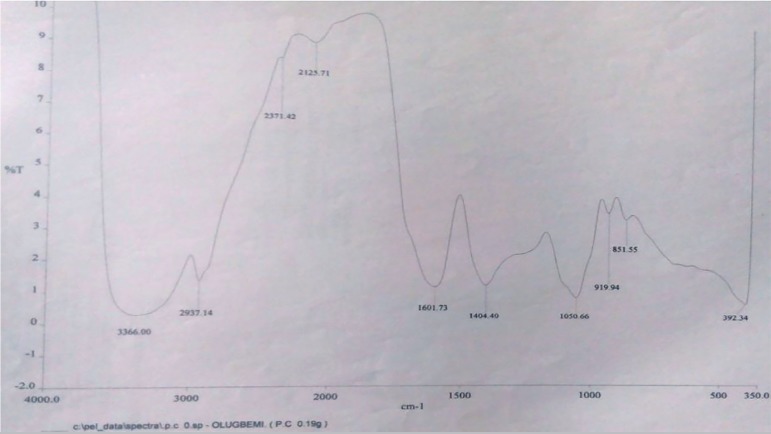
Fourier Transform Infrared (FTIR) analysis of the flavonoid
fraction